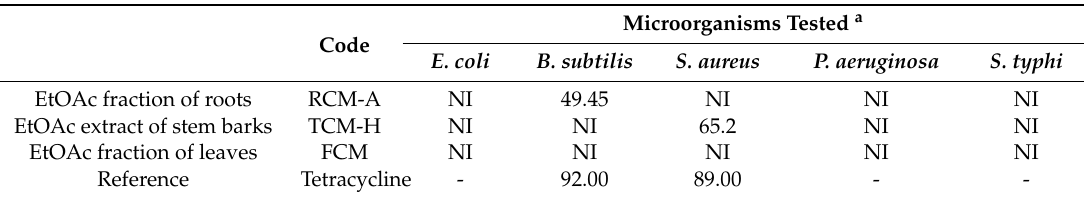
Table 4. In vitro antibacterial activity of Cordia